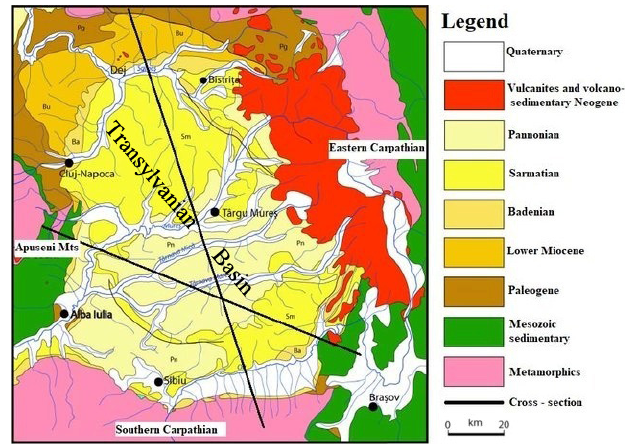
Figure 2. Geological map of the Transylvanian Basin. After [8] modified.